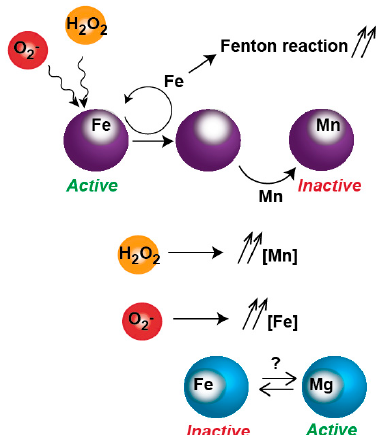
Figure 3. Inactivation of metalloproteins by oxidative stress. Reactive oxygen species (ROS) promotes Fe dissociation from Fe-protein. The apo-protein is re-metallated with Fe or other metals such as Mn. The mis-metallated protein becomes resistant to ROS but is inactive. In O 2 − presence, free Fe is increased, possibly poisoning non-Fe